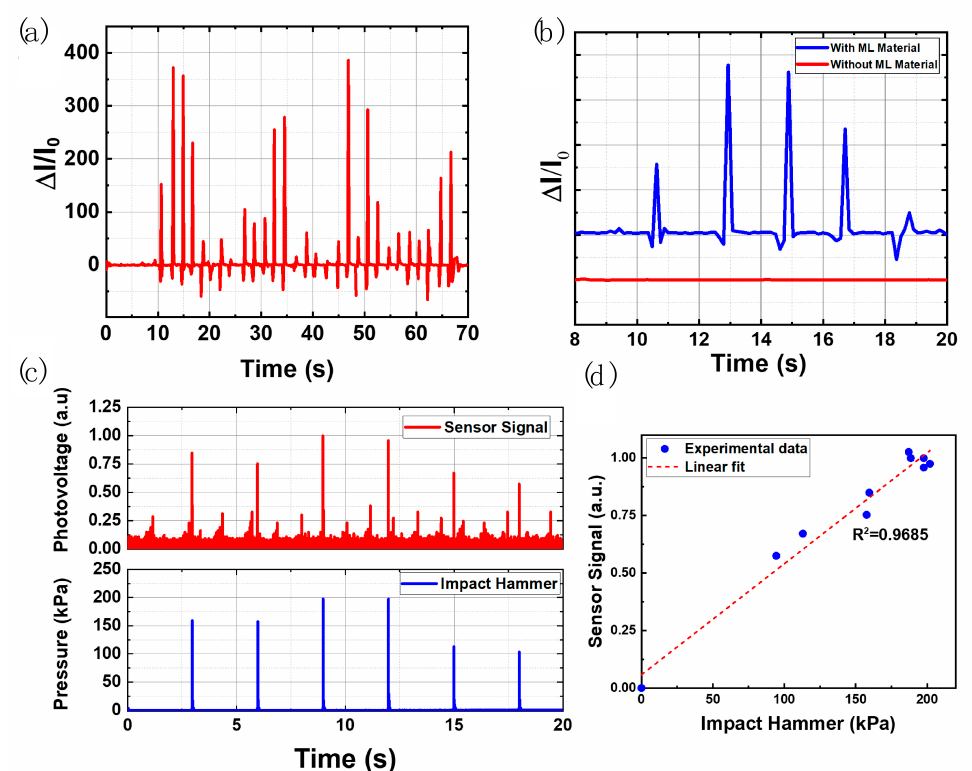
Figure 8. ( a ) Sensor response from the tapping test. ( b ) Comparison between the response signals from the sensor with ML material (blue) and without ML material (red). ( c ) Sensor response from the hammer impact test. ( d ) Correlation between the impact hammer strikes and the sensor signal.